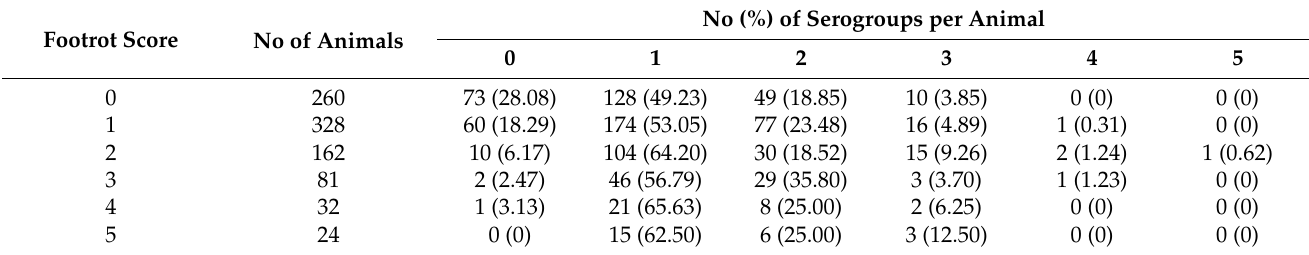
Table 6. Number (No) and percentage of serogroups per animal by the clinical footrot scores. The percentages refer to the total number of animals with the respective